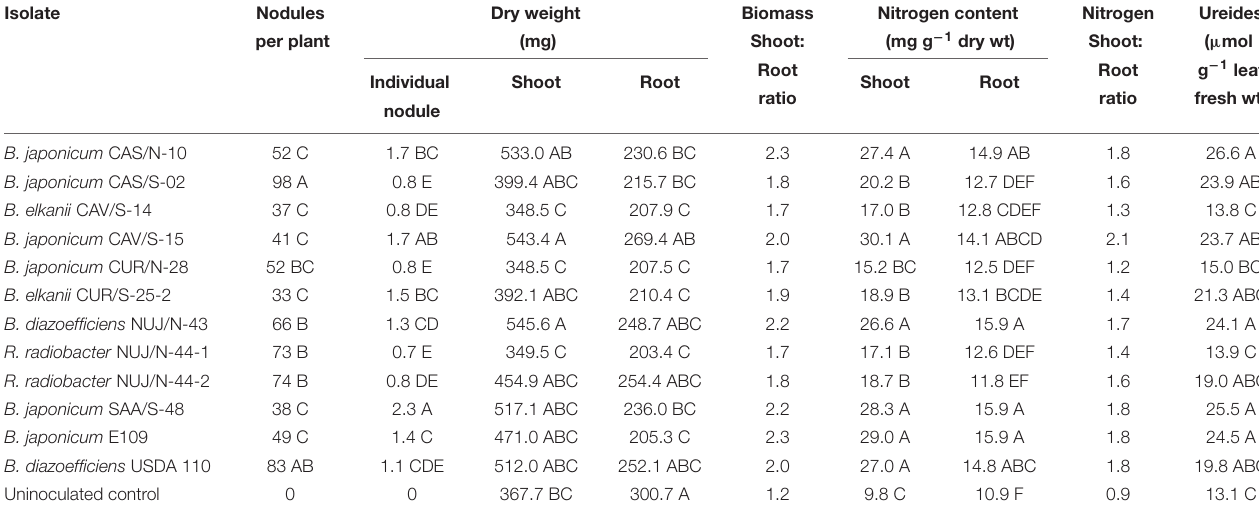
TABLE 3 | Symbiotic performance of SNAP-isolates. B. japonicum E109 and B. diazoefficiens USDA 110 were included as reference strains. Isolate Nodules Dry weight Biomass Nitrogen content Nitrogen Ureides per plant